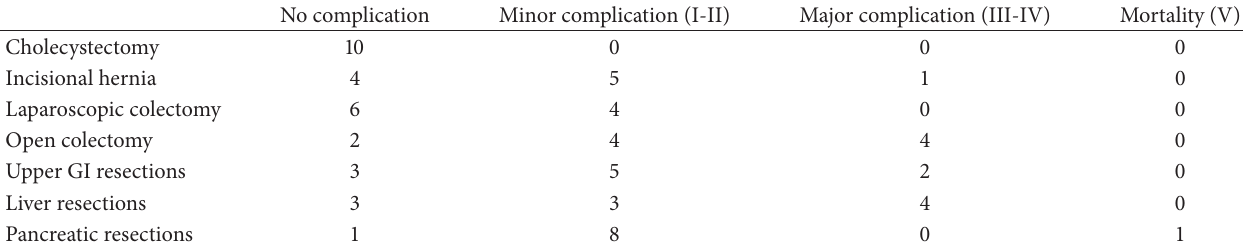
Table 2: Complications according to Dindo-Clavien, according to the type of surgery